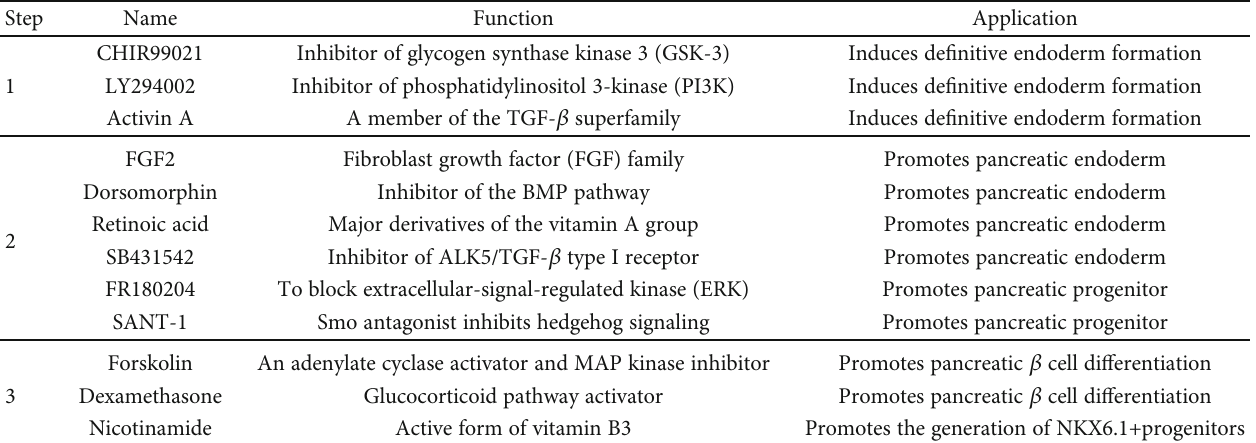
Table 1: Function and application of small molecules in the di ff erentiation of cells into insulin-producing